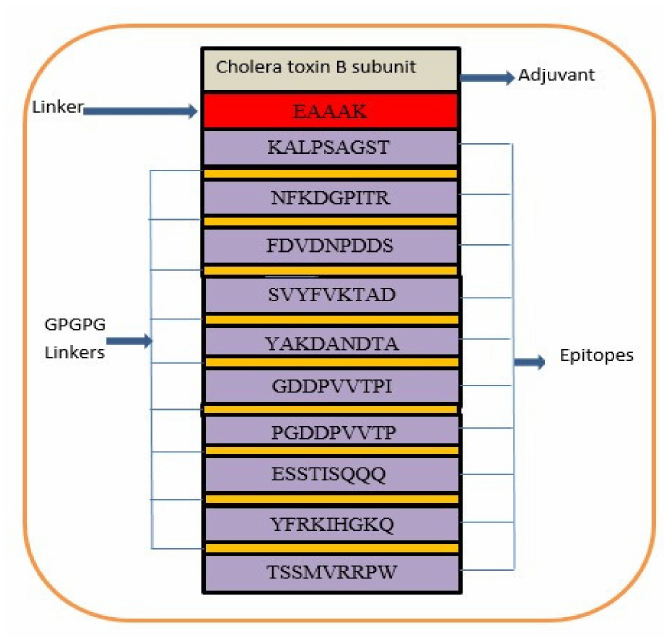
Figure 4. Schematic presentation of final vaccine epitope construct.